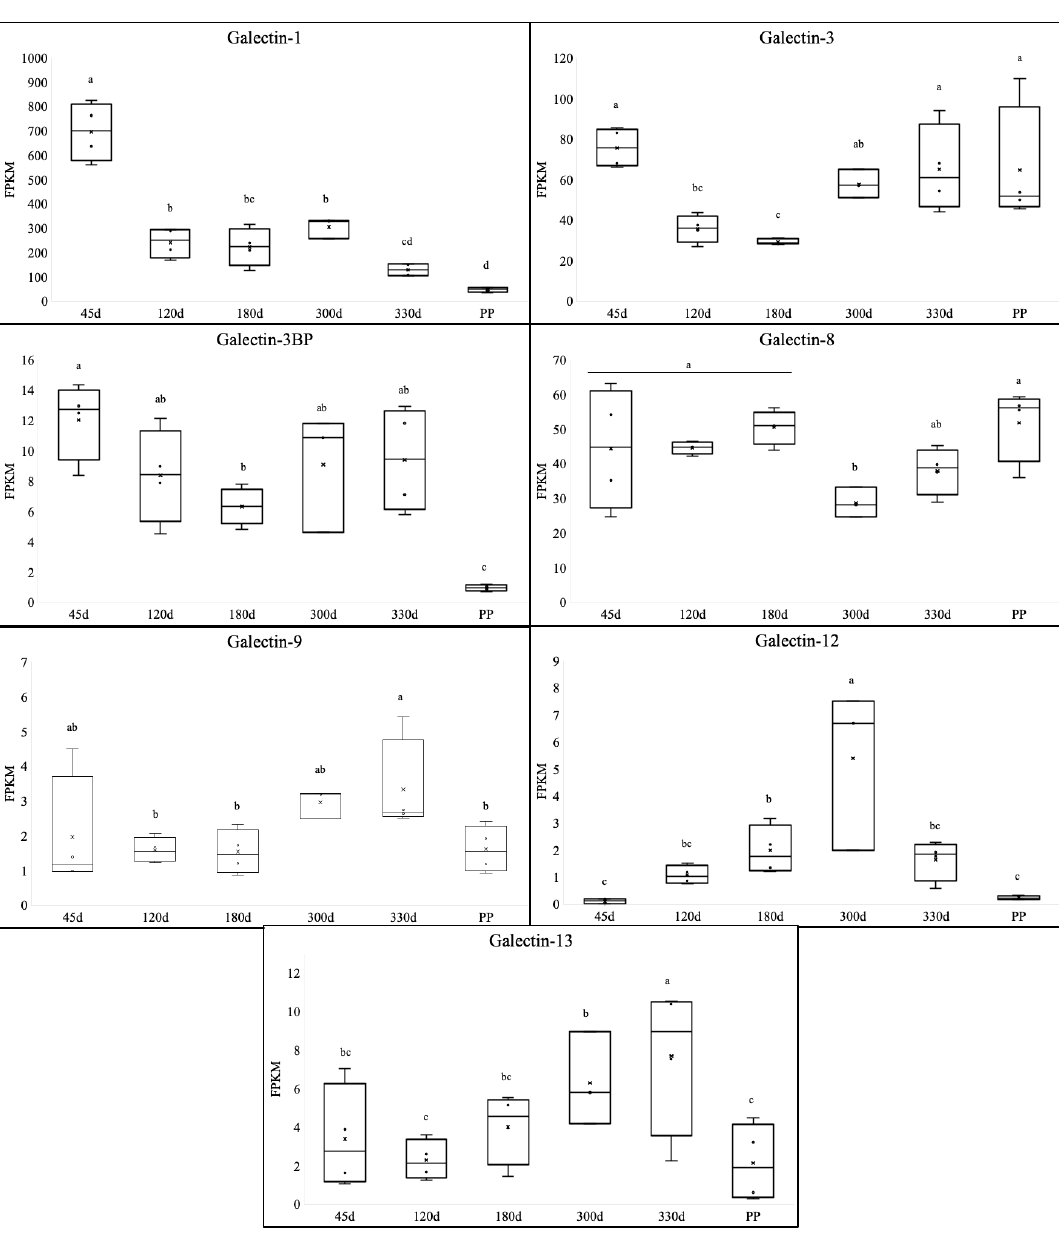
Figure 2. Expression of galectins in the chorioallantois during equine gestation. The expression of galectin-1 was highest in the 45 d chorioallantois and experienced a precipitous decline at 120 d, and expression levels remained low throughout the remainder of gestation, in addition to post- partum. Galectin-3 expression was also high in 45 d chorioallantois and experienced a decline in mid-gestation, but the expression levels of galectin-3 elevated during late-gestation and remained elevated postpartum. A similar profile was noted for galectin-3BP and galectin-9, where expression was high in 45 d chorioallantois, decreased in mid-gestation (120 d/180 d), increased in late-gestation (300 d/330 d), and had a precipitous decline in the postpartum chorioallantois. Galectin-8 remained in a relative steady-state throughout gestation, and only a decrease between 180 d and 300 d was noted. In contrast, galectin-12 expression was highest at 300 d of gestation, with decreased expression both in early- and mid-gestation, in addition to postpartum. All gene expression data are displayed as the fragments per kilobase of exon per million mapped (FPKM) ± SEM. a,b,c,d values with different superscripts differ; p <